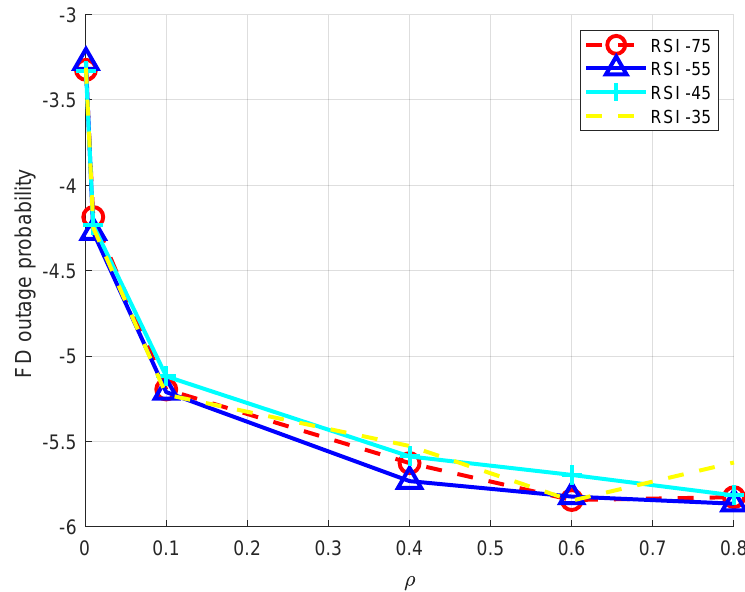
Figure 11. Full-duplex outage probability comparison with PS factor. As shown in Figure 12, we compared the capacity in the half-duplex and full-duplex DF systems. With the same parameter ρ and transmit SNR, the capacity in the full-duplex system is greater than in the half-duplex system. Obviously, the performance of the full- duplex system is better than the half-duplex system. Though a residual interference exists, the full-duplex relay reduces the time slot and improves the spectral